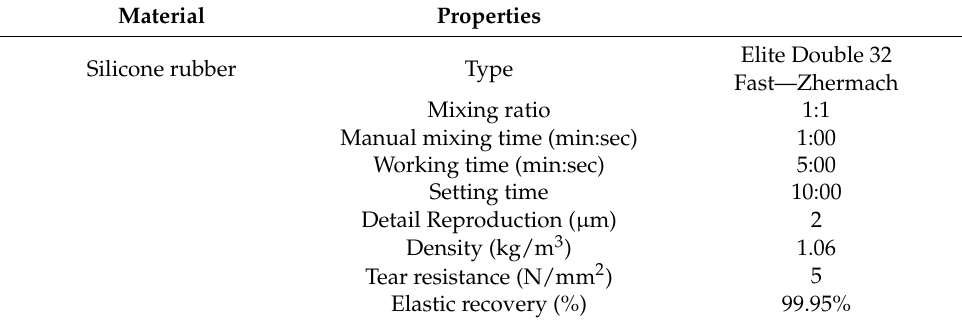
Table 1. Material Properties of the silicone rubber.